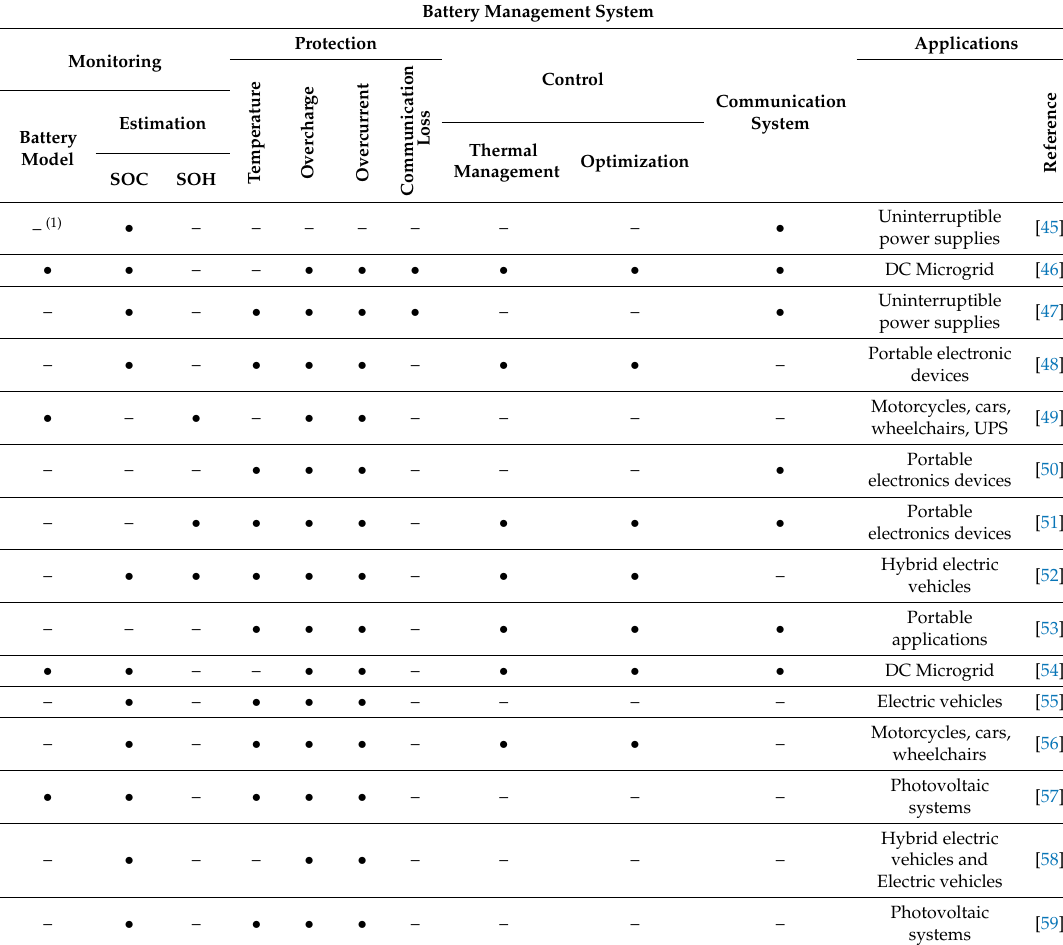
Table 2. Comparative table of some battery charging